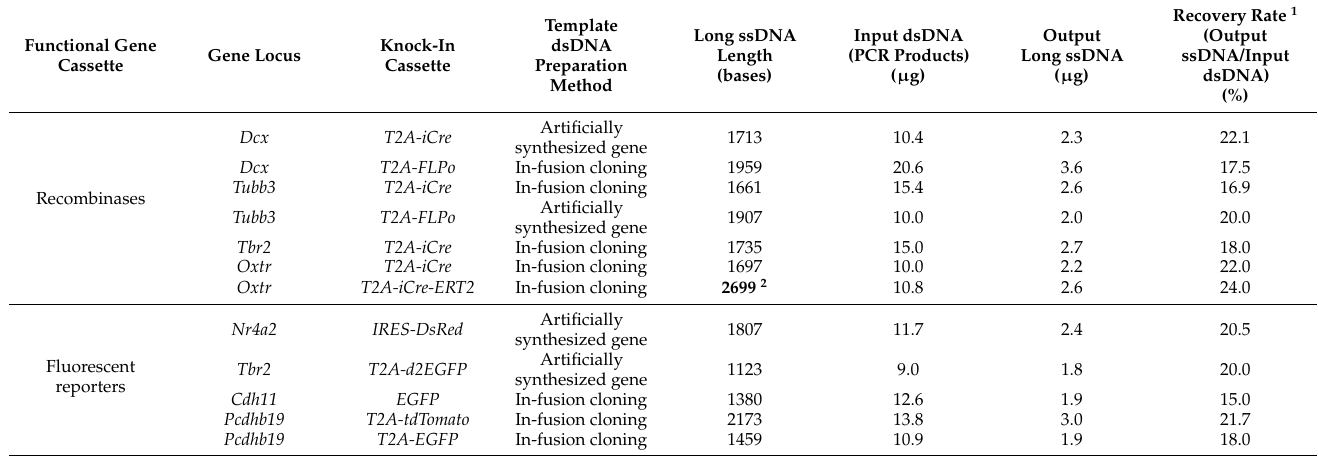
Table 1. Summary of long ssDNA recovery rates in the phospho-PCR